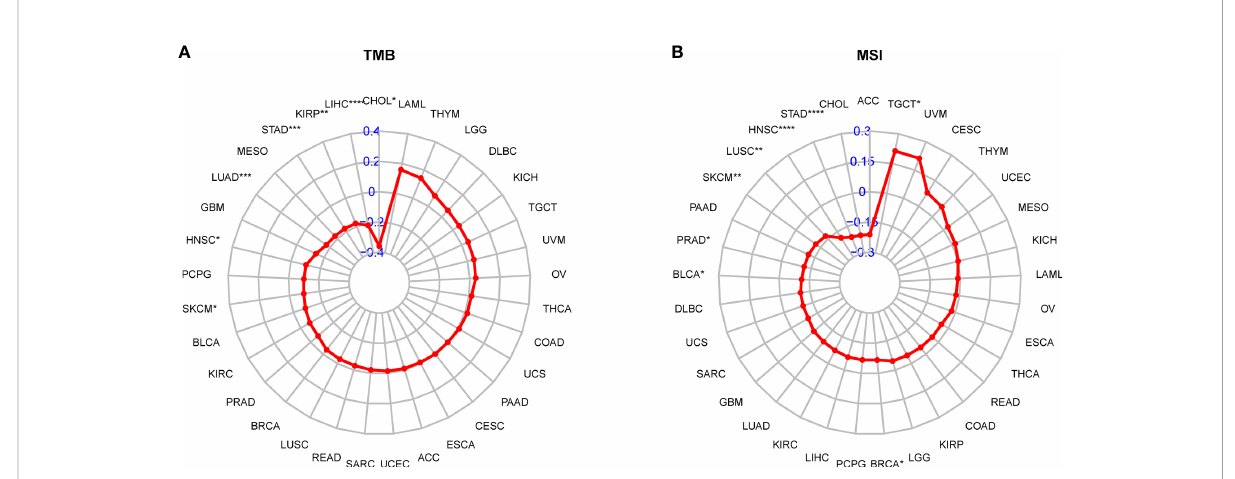
FIGURE 8 Correlation between the AR score and immunotherapeutic biomarker. (A) Radar plot represents the correlation between the AR score and tumor mutation burden (TMB). (B) Radar plot represents the correlation between the AR score and microsatellite instability (MSI). *P < 0.05, **P < 0.01, ***P < 0.001, ****P <